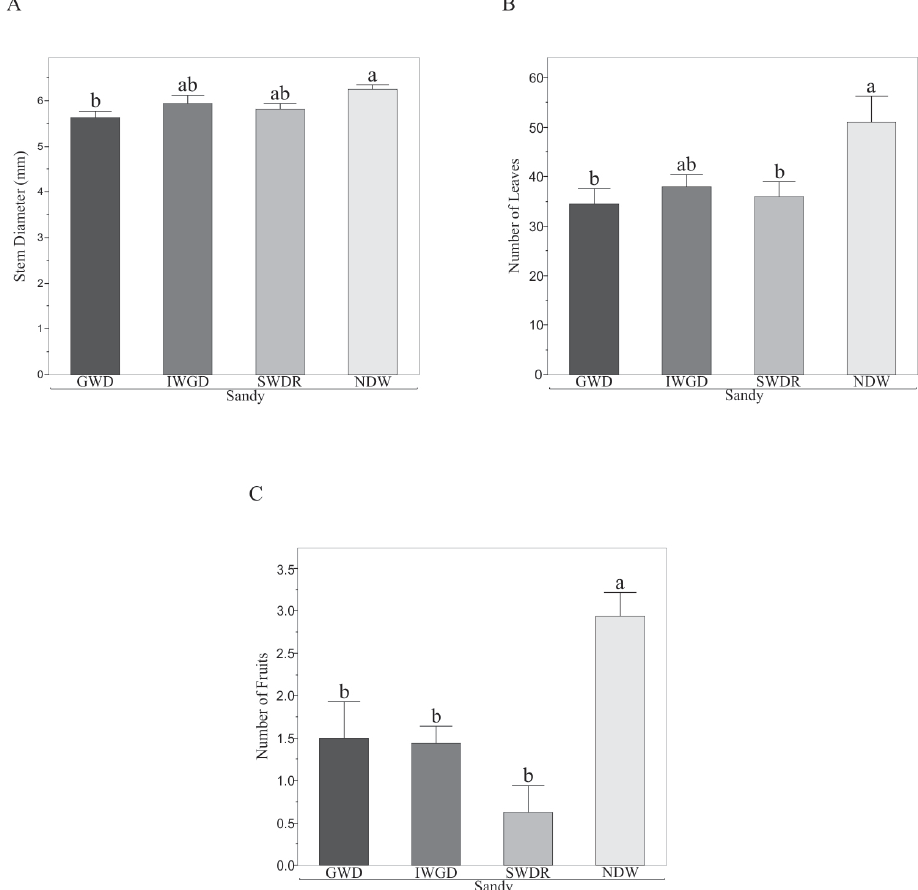
Figure 9. Performance of chili pepper plants grown in sandy soil. Results of the comparison of means ± S.E. by using Tukey ′ s test of the morphological variables. ( A ) Stem diameter; ( B ) Number of leaves; ( C ) Number of fruit. In all cases, p = 0.05. Gradual water deficit (GWD), initial waterlogging with gradual water deficit (IWGD), sudden water deficit with gradual recovery (SWDR), no deficit of water (NDW).